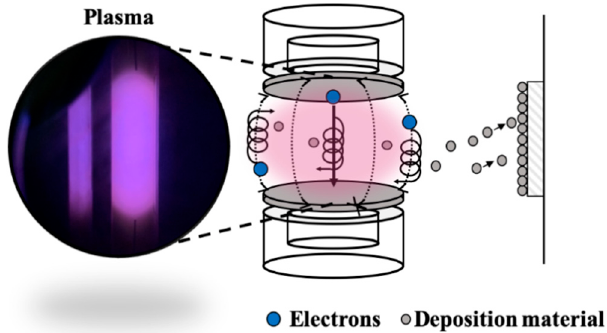
Figure 2. Schematic image of the facing targets sputtering (FTS) system.